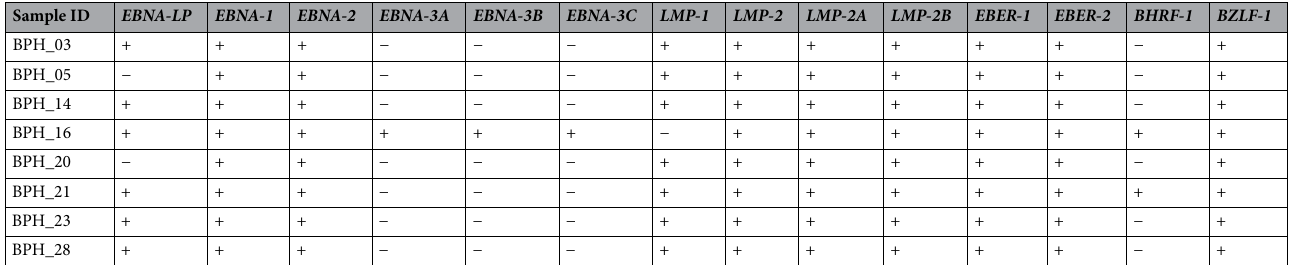
Table 4. Characterization of EBV latency profile in EBV-positive BPH samples. The latency profile was mapped based on the expression of the following latency-associated genes: EBNA-3B, EBNA-3A,